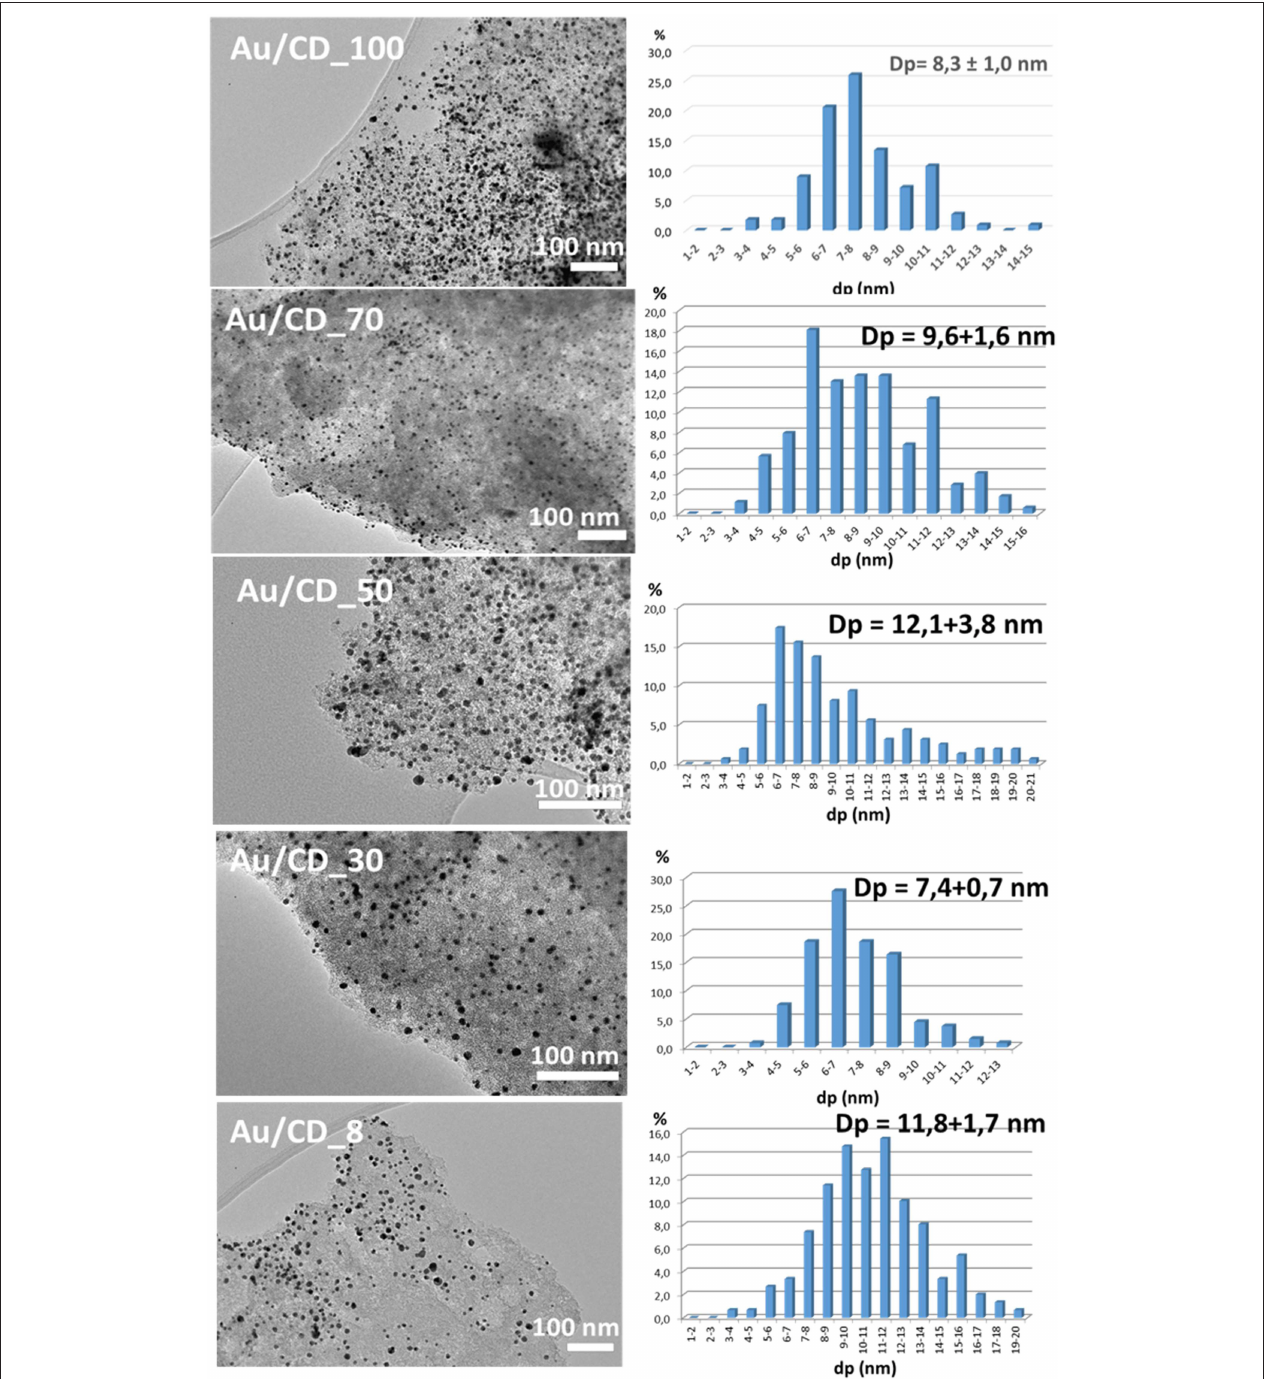
FIGURE 5 | TEM micrographs and gold particle size for Au/C catalysts.